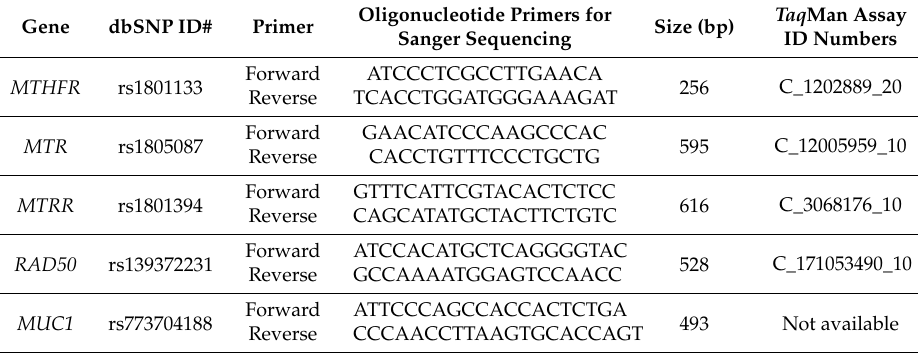
Table 3. Oligonucleotide primers used for conventional polymerase chain reaction (PCR) and Sanger sequencing, and the identification numbers of commercially available Taq Man assays used for real-time